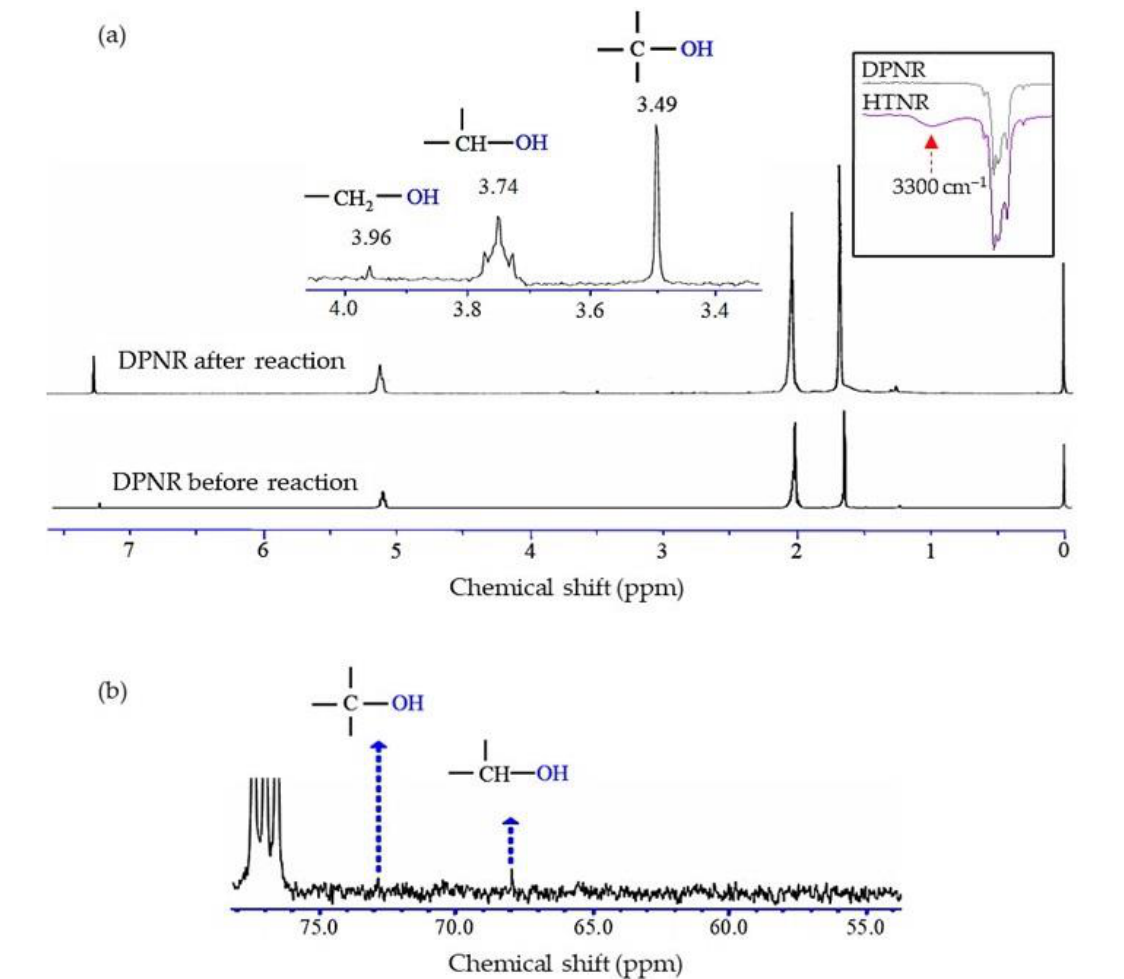
Figure 5. ( a ) 1 H-NMR and FT-IR spectra of DPNR before and after the photochemical reaction (DPNR and HTNR) under UV for 6 h with TiO 2 film deposited on quartz substrate, and H 2 O 2 ( b ) 13 C-NMR spectrum of DPNR after the photochemical reaction.